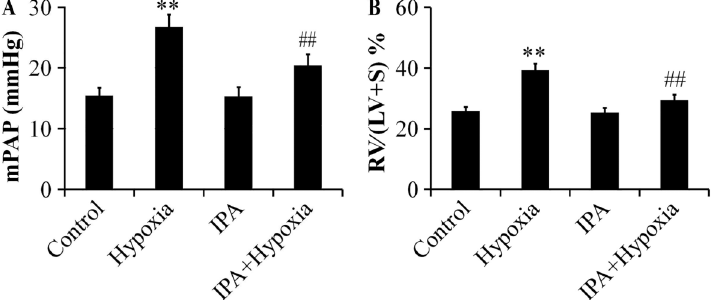
Figure 1. Effects of inactivated P. aeruginosa on mean pulmonary artery pressure (mPAP) ( A ) and on the right ventricle (RV)/left ventricle plus the interventricular septum (LV + S) thickness ratio ( B ) in rats (n=6). Hypoxia induced an increase of mPAP (P o 0.01), and treatment with IPA effec- tively attenuated this increase. The RV/(LV + S) % was markedly elevated in the rats in hypoxia group and IPA attenuated the RV/(LV + S) %. Data are reported as mean ± SD. **P o 0.01 vs control; ## P o 0.01 vs hypoxia (ANOVA).